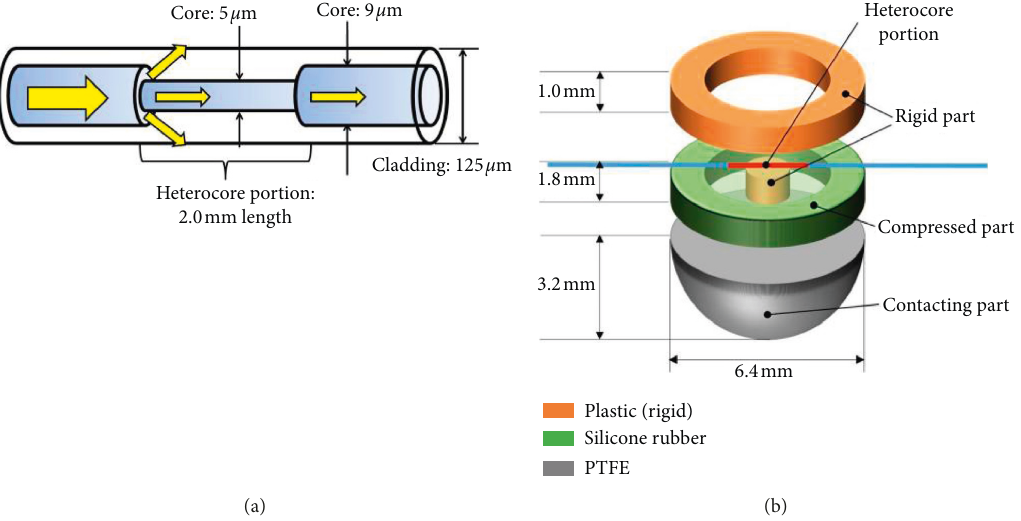
Figure 4: Schematic illustration showing the structure of the hemispheric tactile sensor: (a) the structure of a heterocore fiber optic sensor and (b) the structure of a hemispheric of a hemispheric heterocore fiber optic tactile sensor (adapted from Ref. [78] Copyright (2018), with